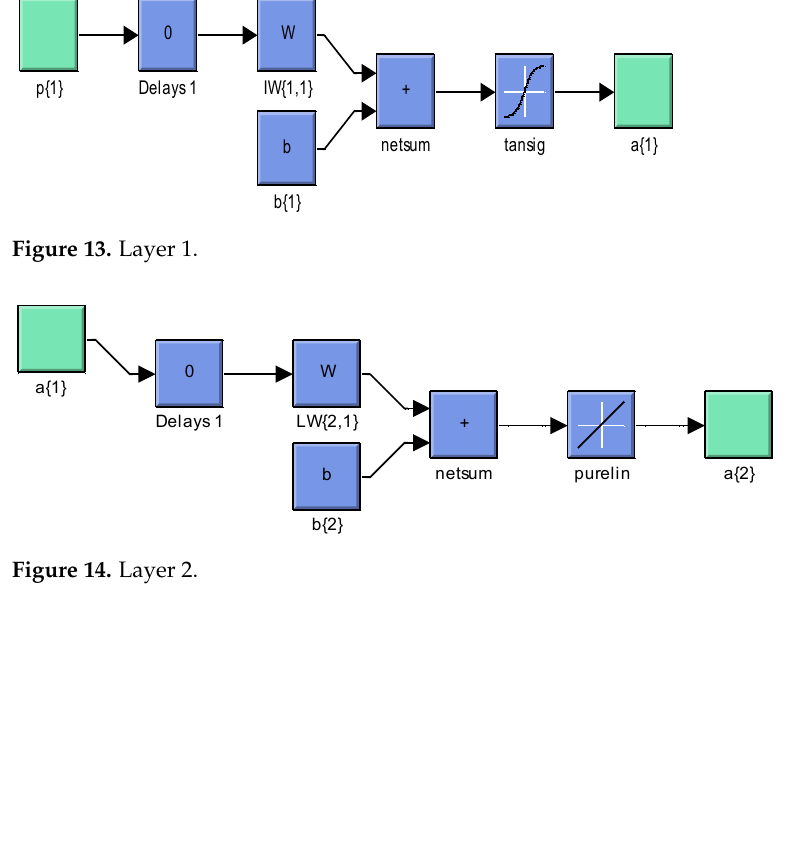
Figure 13. Layer 1. Figure 13. Layer 1.